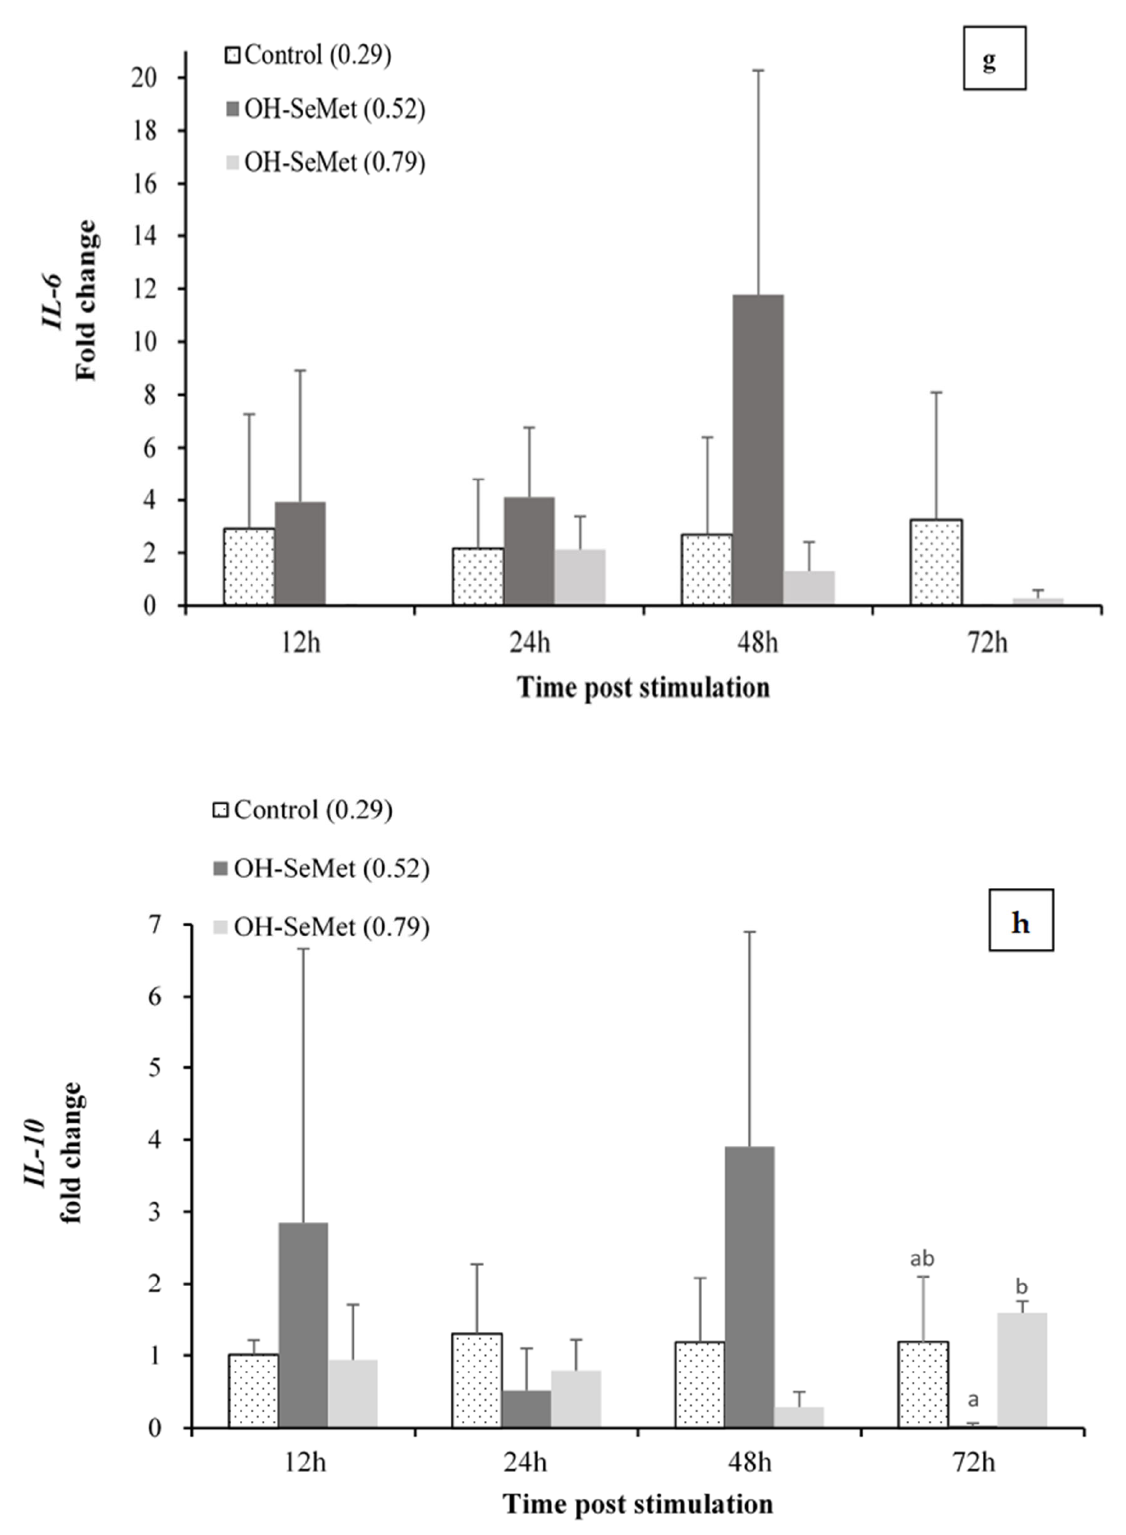
Figure 4. Relative expression (fold changes in relation to the values of the control diet) of selected immune response genes in liver (( a ): Mx ) and head kidney (( b ): TNF- α ; ( c ): COX ; ( d ): IL-Ir2 ; ( e ): Casp-3 ; ( f ): IL-1 β ; ( g ): IL-6 ; ( h ): IL-10 ) of gilthead seabream fed diets with different supplementation of OH-SeMet along the anti-viral response challenge.